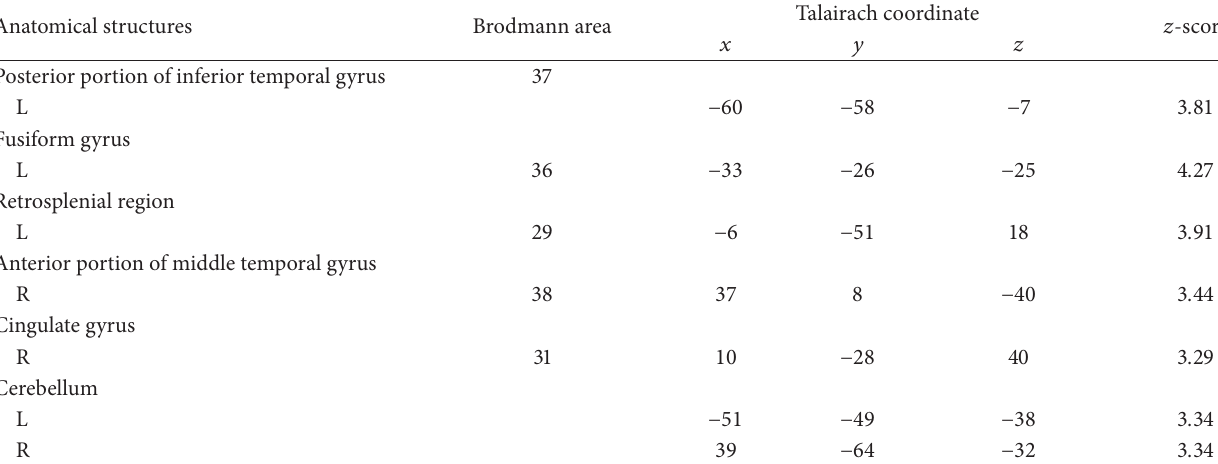
Table 3: Regions showing significant changes in rCBF by the subtraction of complex minus simple condition. Anatomical